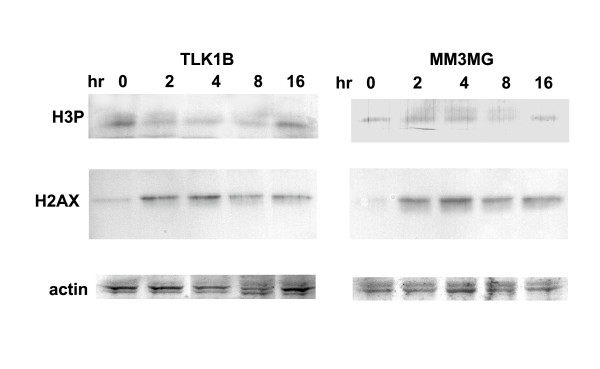
Phosphorylation of H3 and H2AX after irradiation in the presence of wortmannin. The experiment was carried out as detailed in the legend to Fig. 2, but the cells were pre-treated with 30 μM wortmannin to inhibit ATM.